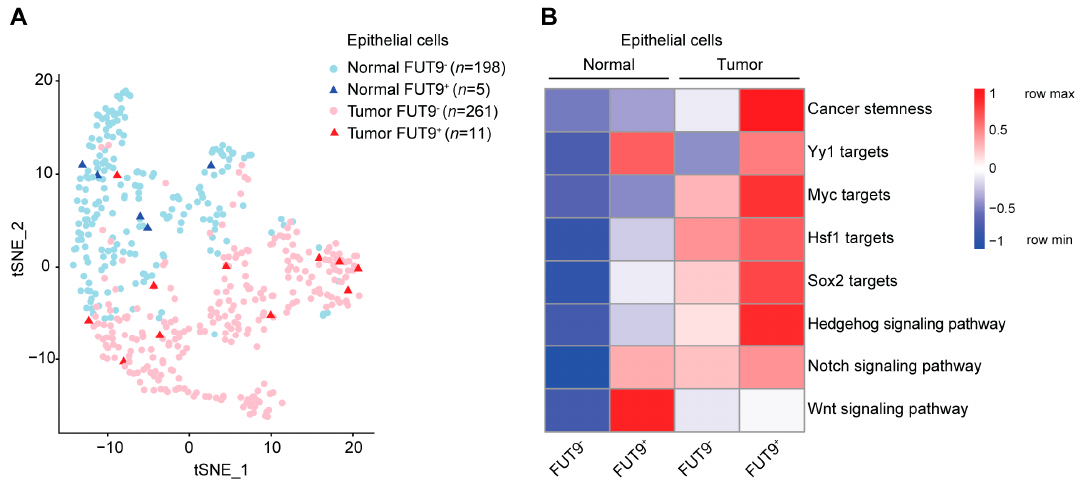
Figure 5. FUT9-specific transcriptional programming of cancer stemness in primary CRC tumor cells. ( A ) Clustering of CRC patient-derived normal and tumor epithelial cells based on FUT9 expression. Expression data were obtained from a previously described single cell-RNA seq analysis [56] and were further analyzed. ( B ) Expression of gene sets related to cancer stemness and pluripotency in the generated FUT9 + and FUT9 - normal and tumor epithelial clusters.